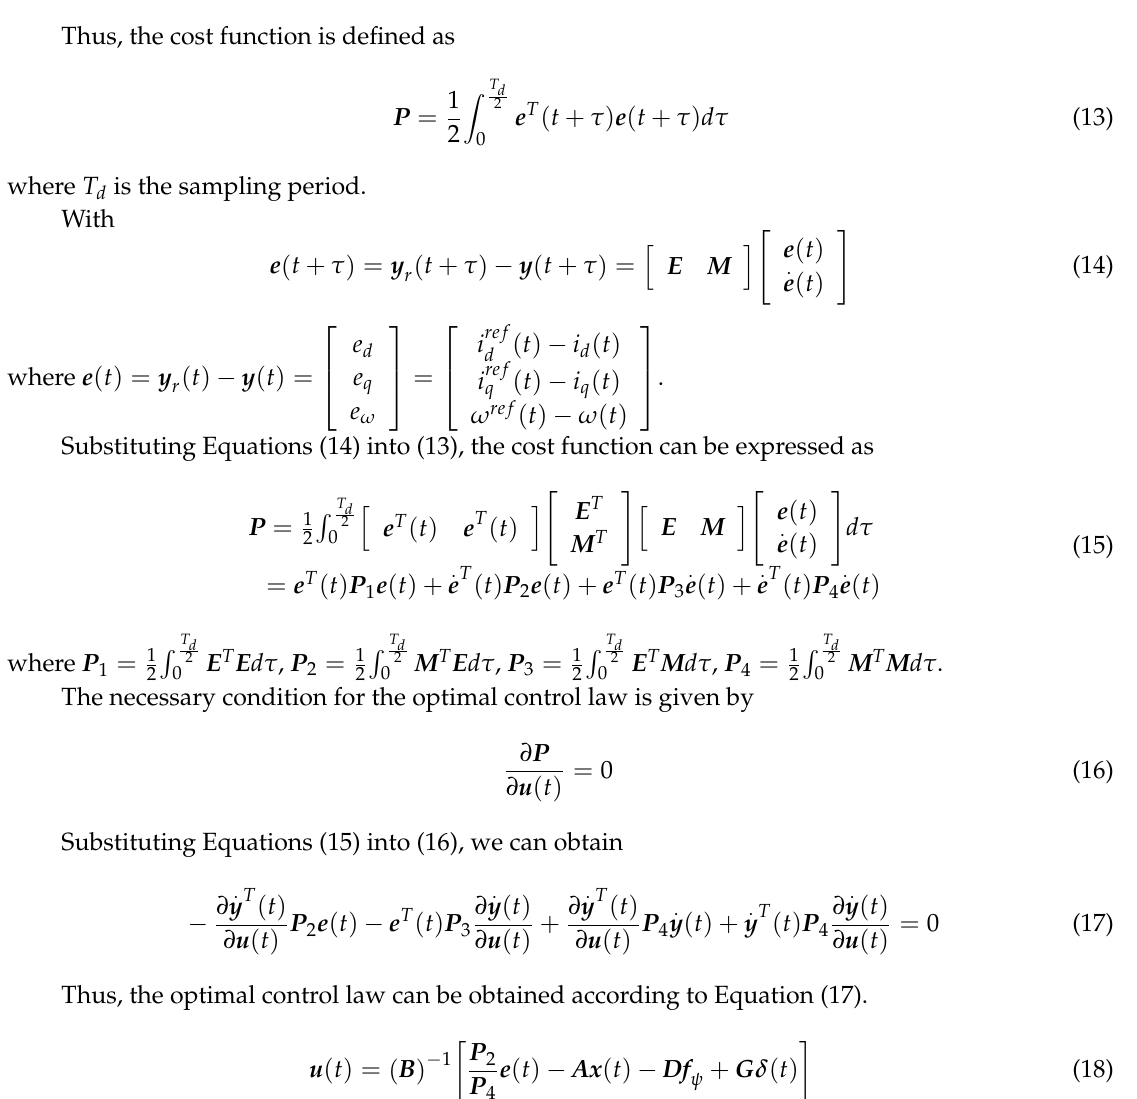
Figure 4. ( a ) Time diagram of conventional predictive control method implementation; ( b ) time diagram of CRFTPC method implementation.